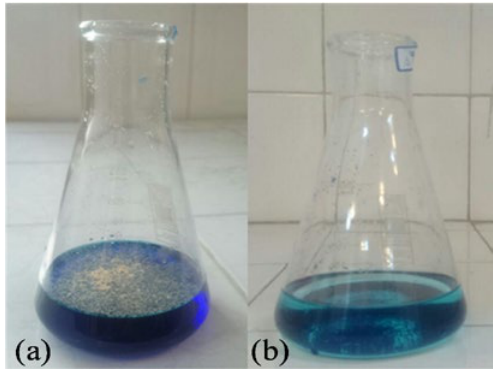
Fig 3. Picture of dye solution before (a) and after (b) the adsorption process using SD/MgO. Fig 3: Picture of dye solution before (a) and after (b) the adsorption process using